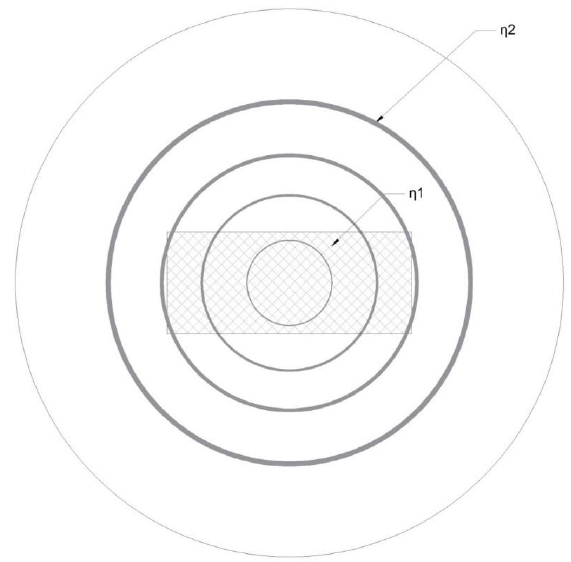
Figure 7. Rectangular core fiber of semi-sides aa and bb , for r < bb , n = n 1 , for r > aa , n = n 2 , for bb < r < aa , n 2 < n < n 1 .